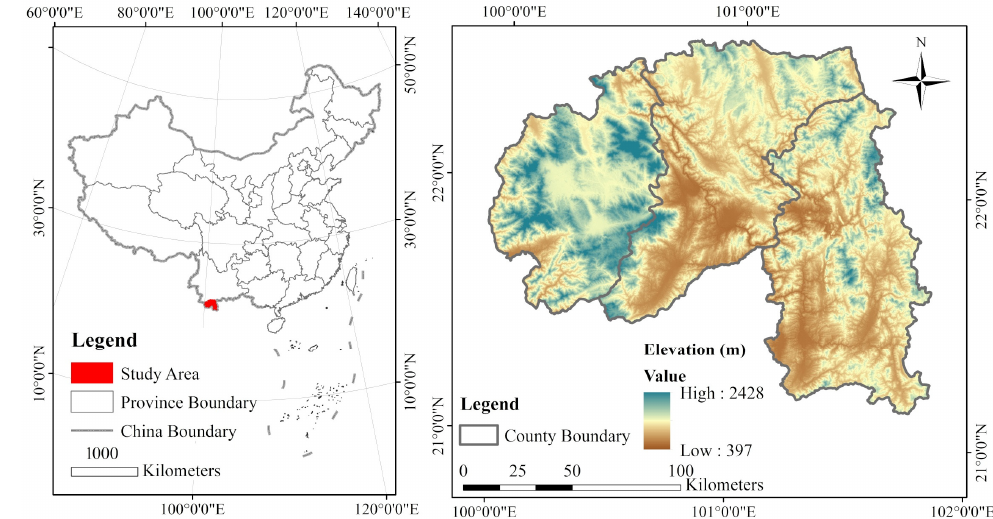
Figure 1. The location of Xishuangbanna in China and its altitudinal range.